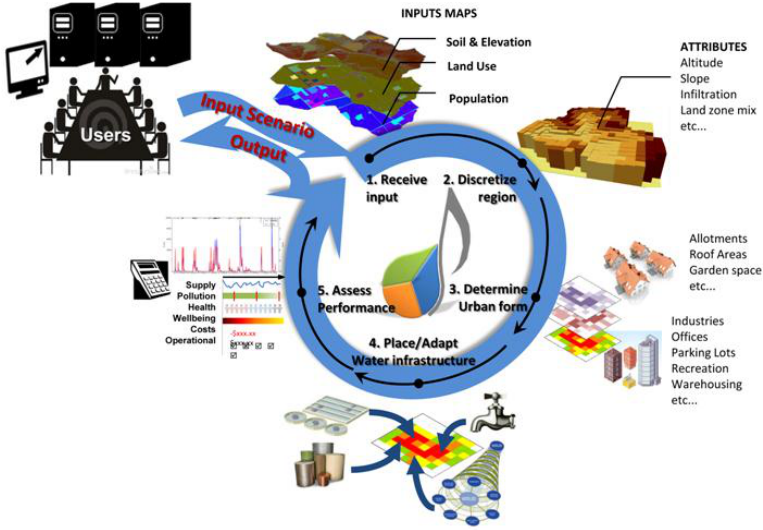
Figure 1. Overview of the UrbanBEATS model (reprinted from [18] with permission from ASCE).